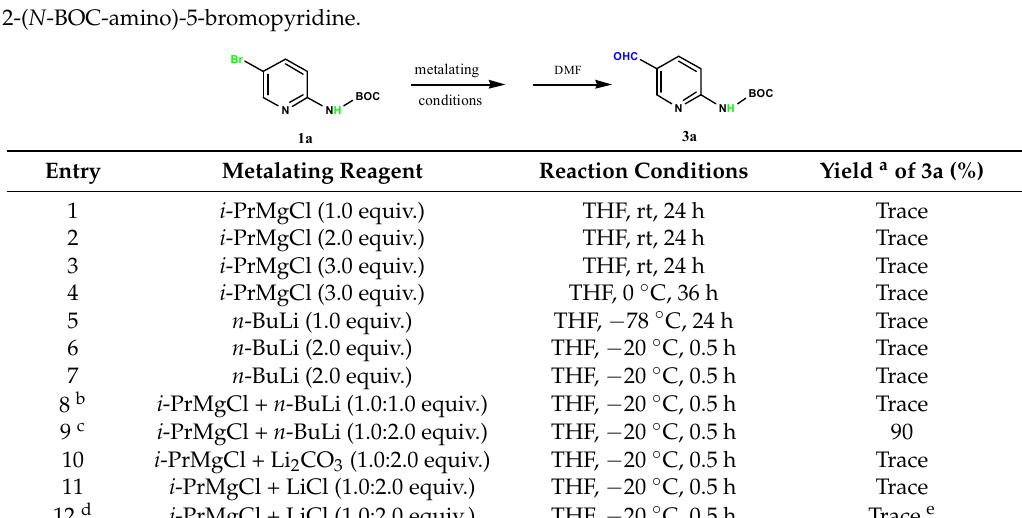
Table 1. Tert-butyl (5-formylpyridin-2-yl) carbamate of metalating reagents prepared from